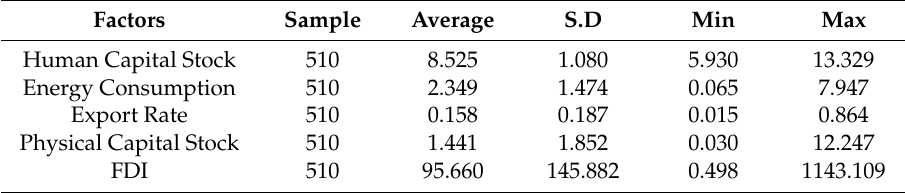
Table 2. Descriptive statistics of the variables used in the